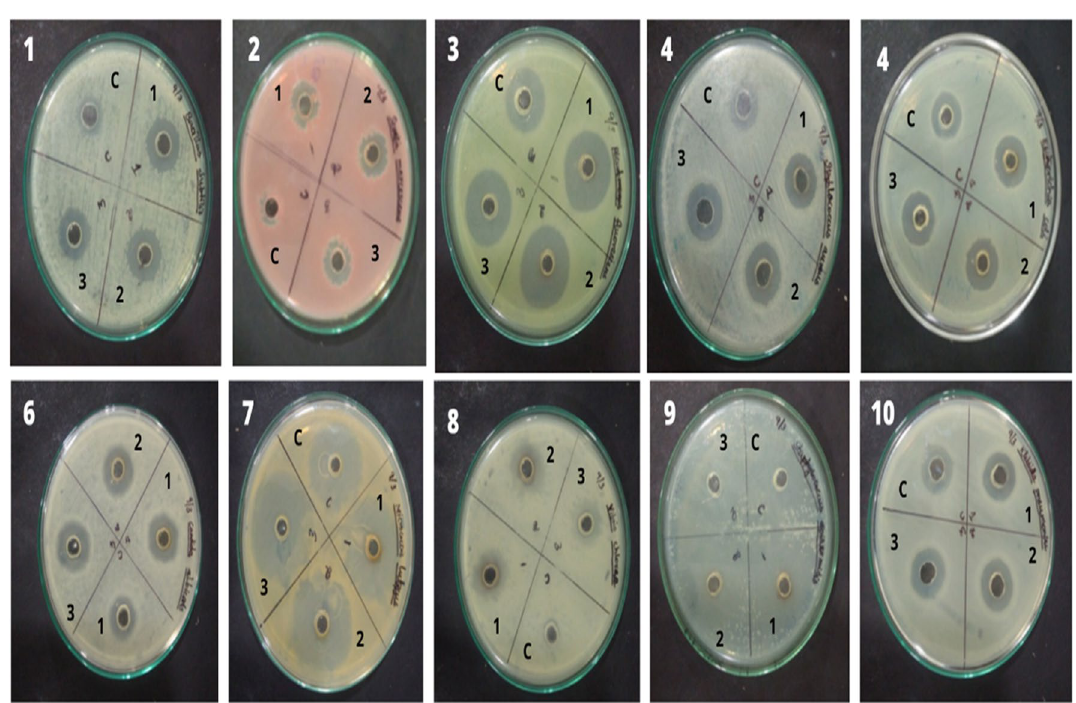
Figure 6. ( A ) Analysis of Silver nanoparticles using SEM of Sargassum polycystum . ( B ) Analysis of Silver nanoparticles using TEM of Sargassum polycystum.